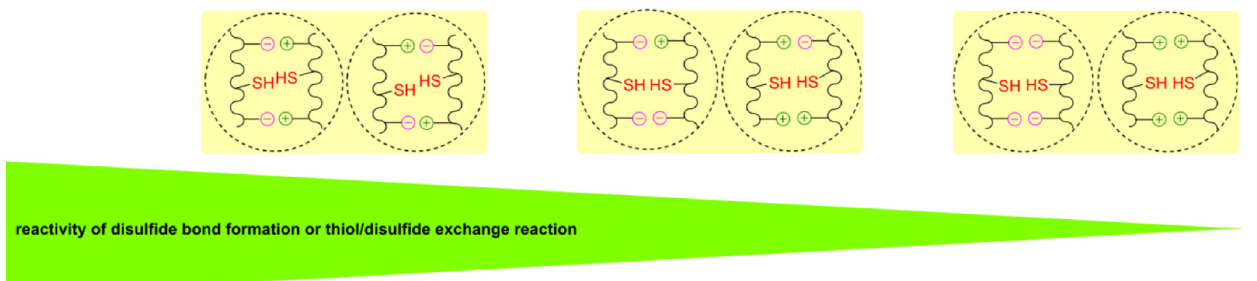
Figure 6. Cartoon showing the influence of electrostatic effects of R groups flanking thiols on their relative rates of thiol-disulfide exchange reactions. Adapted with permission from [2]. Copyright (2019) Elsevier B.V.